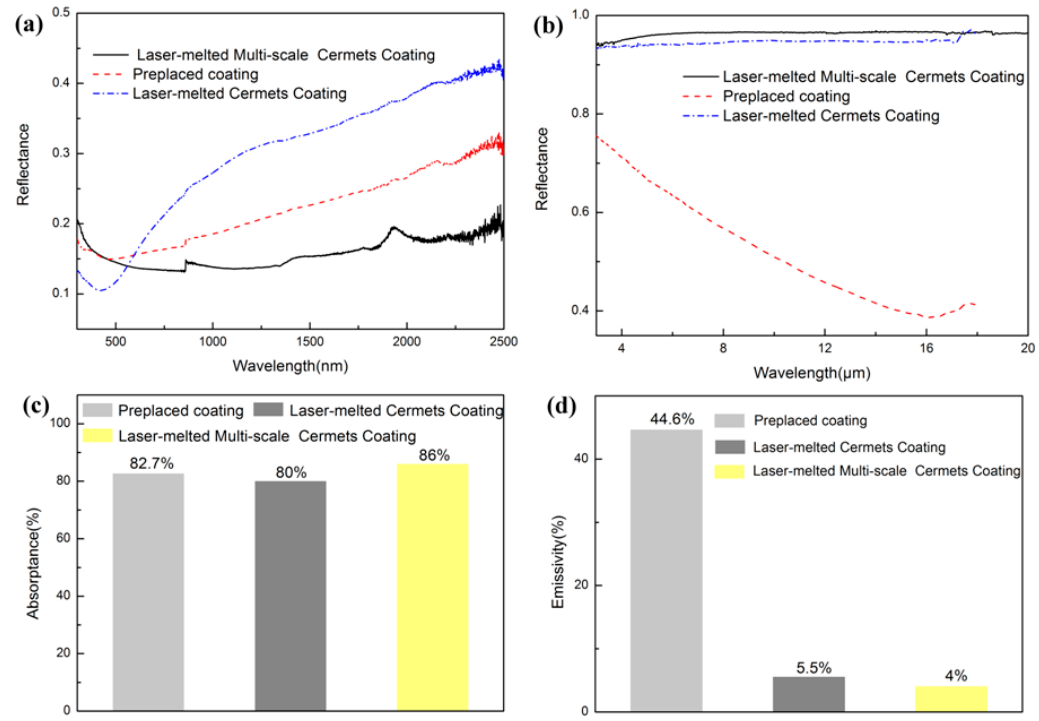
Figure 7. Reflectance spectra and absorption performance of the laser clad cermet coatings: ( a ) reflectance spectra in the UV to near infra-red (IR) regime, ( b ) reflectance spectra in the IR region, ( c ) absorptance of the coatings, and ( d ) emittance of the